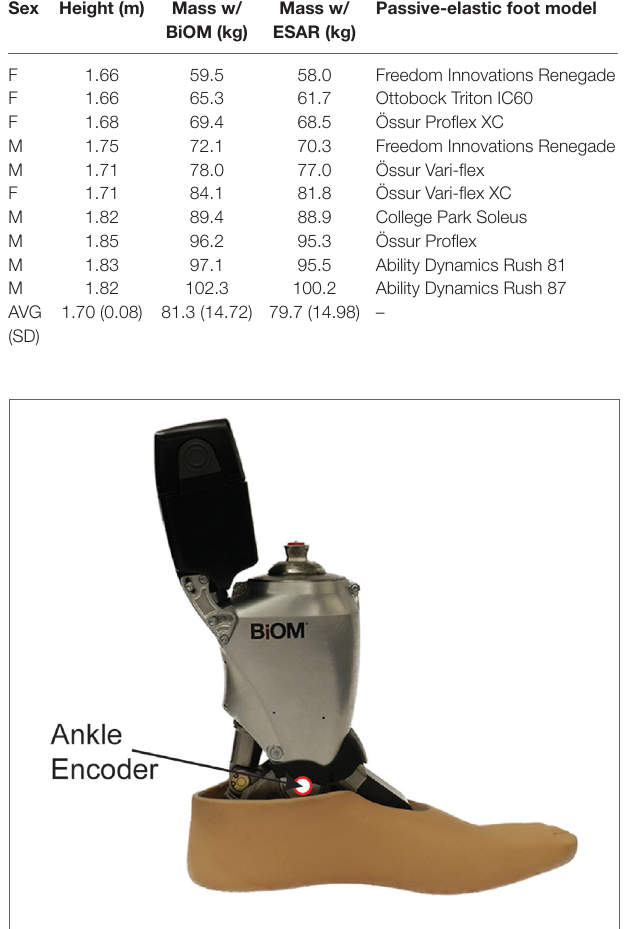
FigUre 1 | “Malleolus” marker placement on the encoder/center of rotation for the BiOM powered prosthesis.